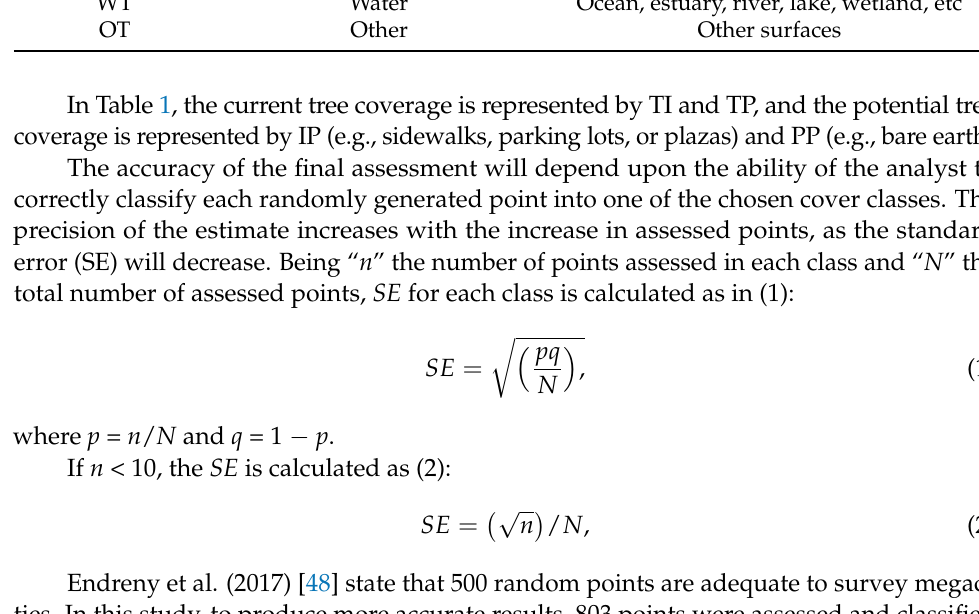
Table 1. Cover classes used for the land cover assessment of the Metropolitan City of Naples. Item Cover Class Description TI Tree over impervious Trees over impervious ground TP Tree over pervious Trees over pervious ground AG Agricultural land Pastures, crops or fallows Grass/herbaceous cover Yards, parks or fields IN Impervious non-plantable Roads, rails, roofs or monuments Pervious non-plantable Dirt road IP Impervious partially plantable Sidewalks, parking lots or plazas PP Pervious partially plantable Bare earth Shrubs/bushes Water Other Other